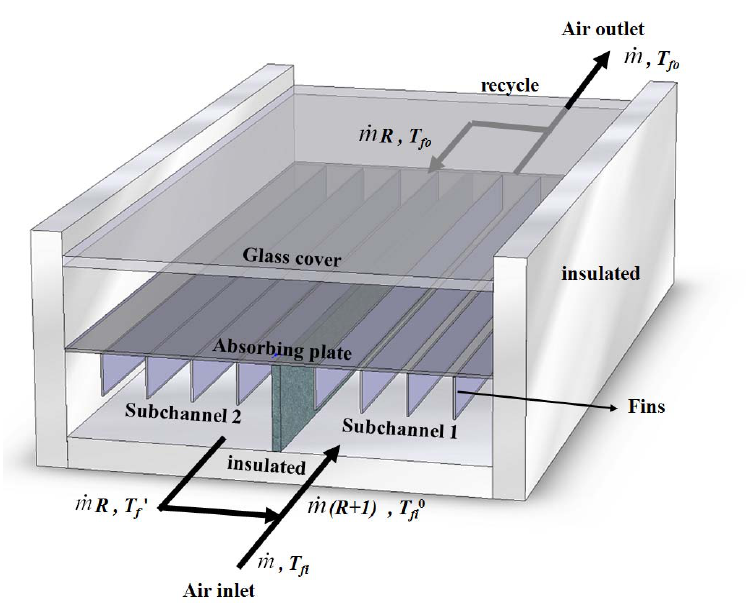
Figure 1. Downward-type solar air collector with internal recycle and fins